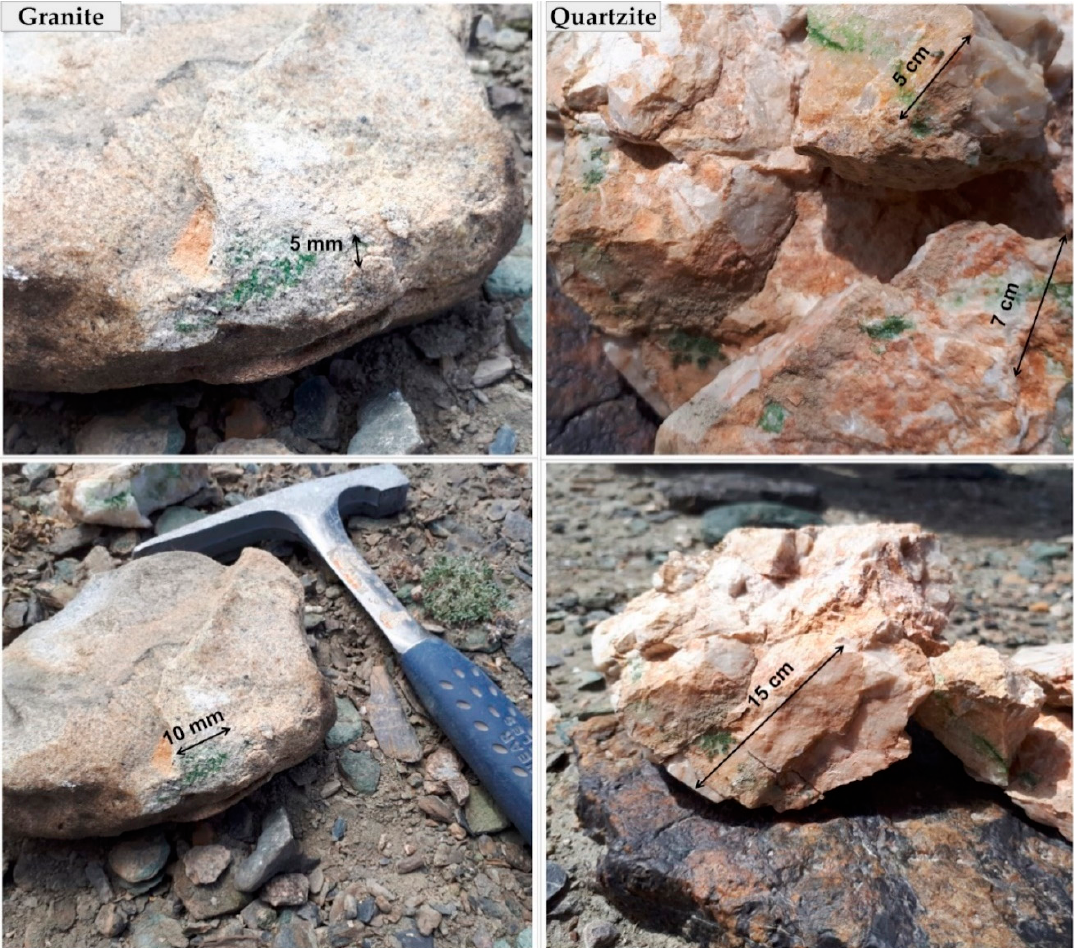
Figure 2. Endolithic biofilms occurring in granites and quartzites in Eastern Pamir. (Granite) the biofilms representing group A (TAKHG). (Quartzite) the samples representing group C (TAKAW1).